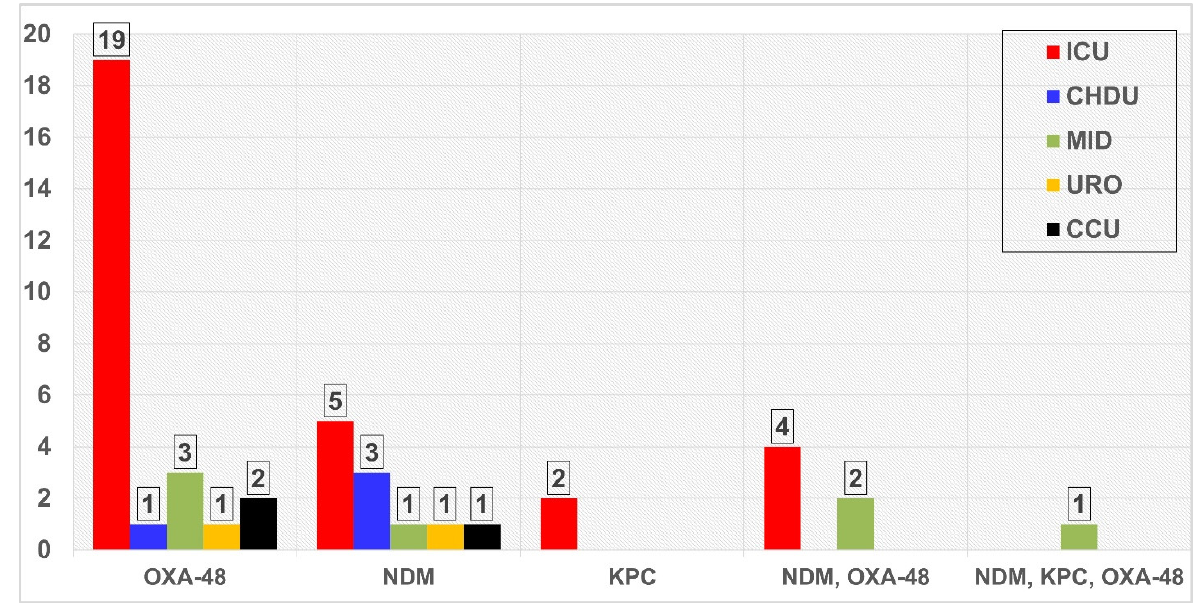
Figure 3. Distribution of carbapenemase-producing MDR. Klebsiella pneumoniae among hospital wards. Table 3. Distribution of resistance-gene-carrying Klebsiella pneumoniae among studied patients based on the number of comorbidities.